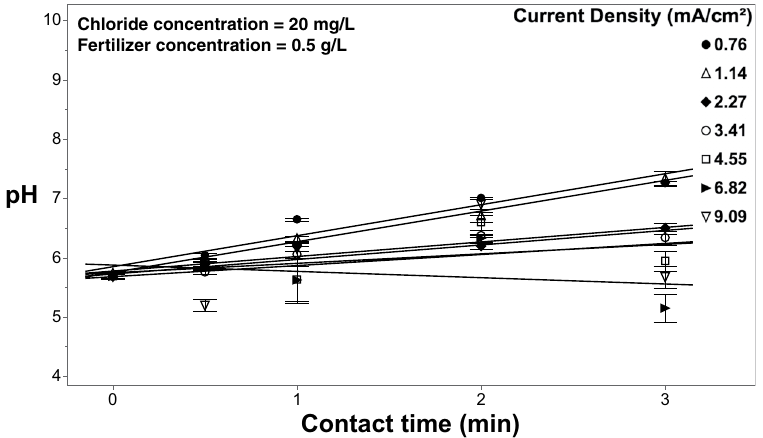
Figure 14. The pH of the solution as a function of current density and contact time with 20 mg/L of chloride and 0.5 g/L of fertilizer in solution and ( b ) effluent free chlorine from the EFC with applying variable current densities and contact times with the same test solution. Error bars are ± SEM, N =